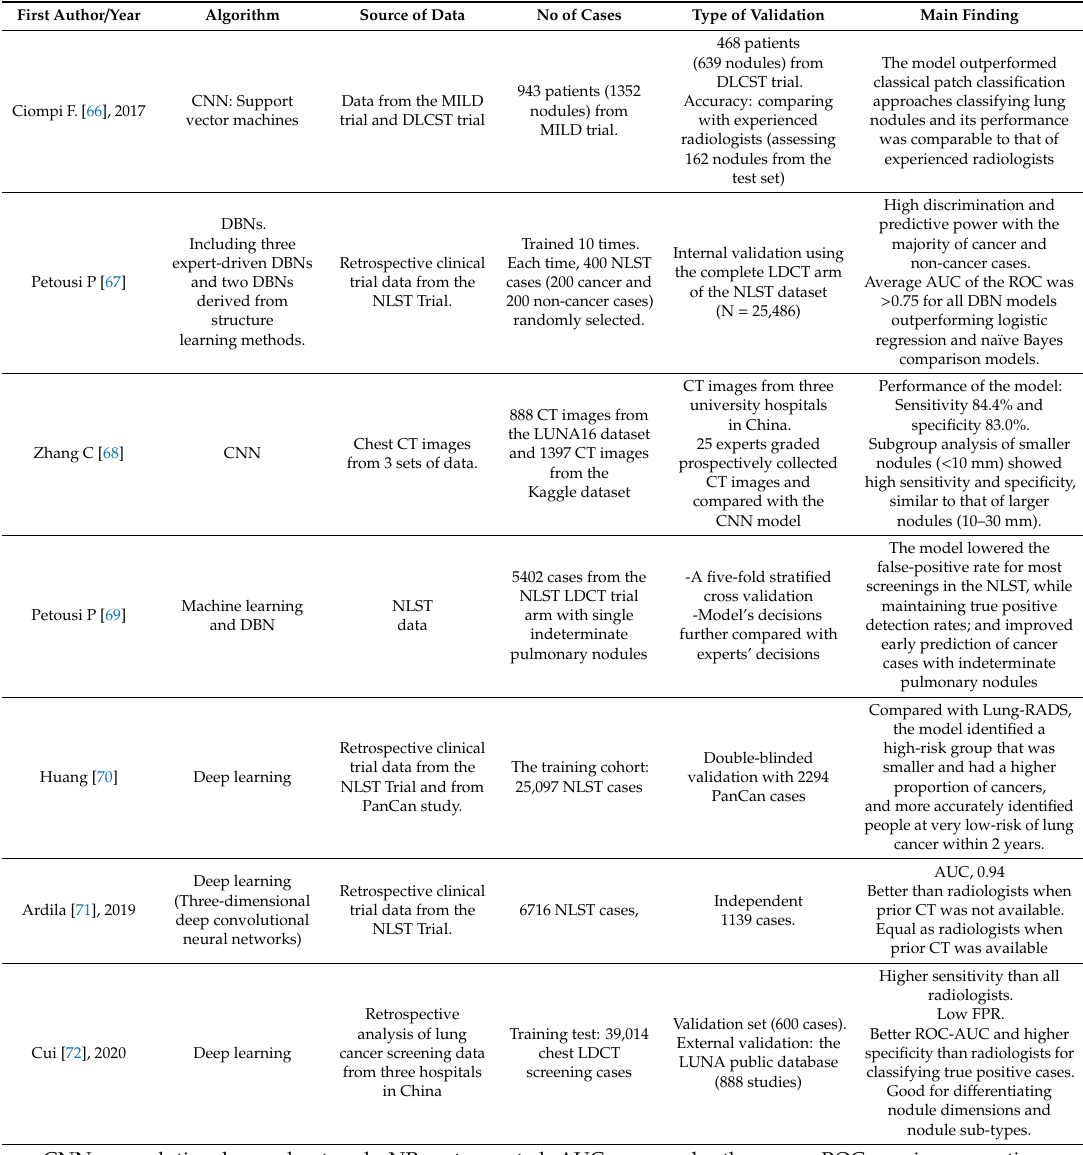
Table 1. Summary of articles in which artificial intelligence (AI) was used to analyze low-dose computer tomography (LDCT) images for lung cancer